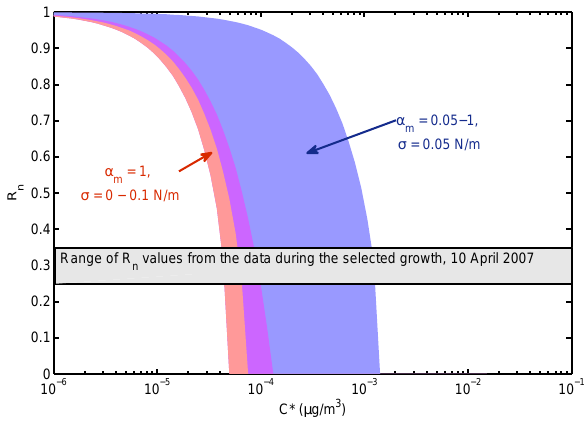
Fig. 8. Predicted R n ( D p , VDMPS / D p , DMPS ) from the kinetic evapo- ration model as a function of C ∗ for 10 April 2007. The blue shaded region shows the sensitivity to the accommodation coefficient ( α m ) while the surface tension ( σ) is held fixed at 0.05Nm − 1 . The pink shaded region shows the sensitivity to the surface tension with the accommodation coefficient held fixed at 1. The purple region is the overlap of the pink and blue regions. The gray box denotes the range of R n values measured by the VDMPS on 10 April 2007. The range of possible C ∗ values is given by the overlap between the pink/blue areas with the gray box (4.5 × 10 − 5 –1.2 × 10 − 3 ) . about 20 nm by around 16:00 local winter time